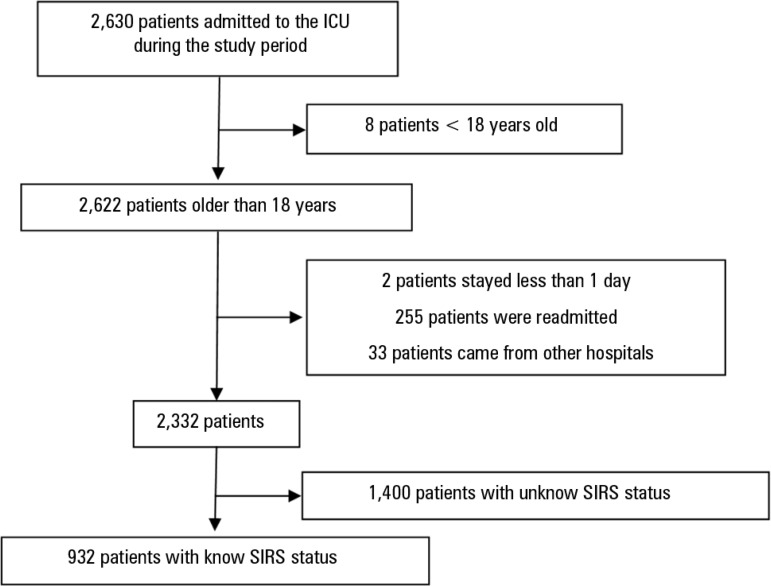
Patient flow diagram of the study.ICU - intensive care unit; SIRS - systemic inflammatory response
syndrome.